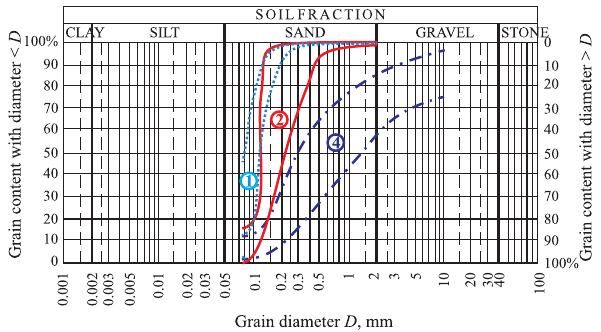
Fig. 1. Grain-size distribution curves from sieve analysis for soils tested in